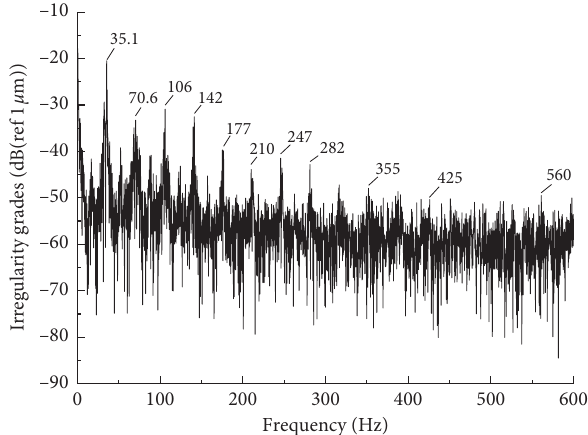
Figure 14: Wear grade